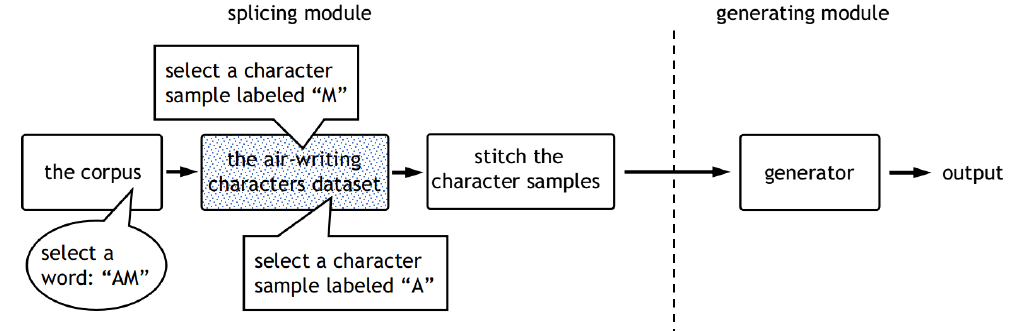
Figure 1. Pipeline of the air-writing word synthesizer. It can be divided into a spicing module and a generating module. The splicing module splices the character samples according to the corpus. The generating module takes in the spliced samples and generates realistic word